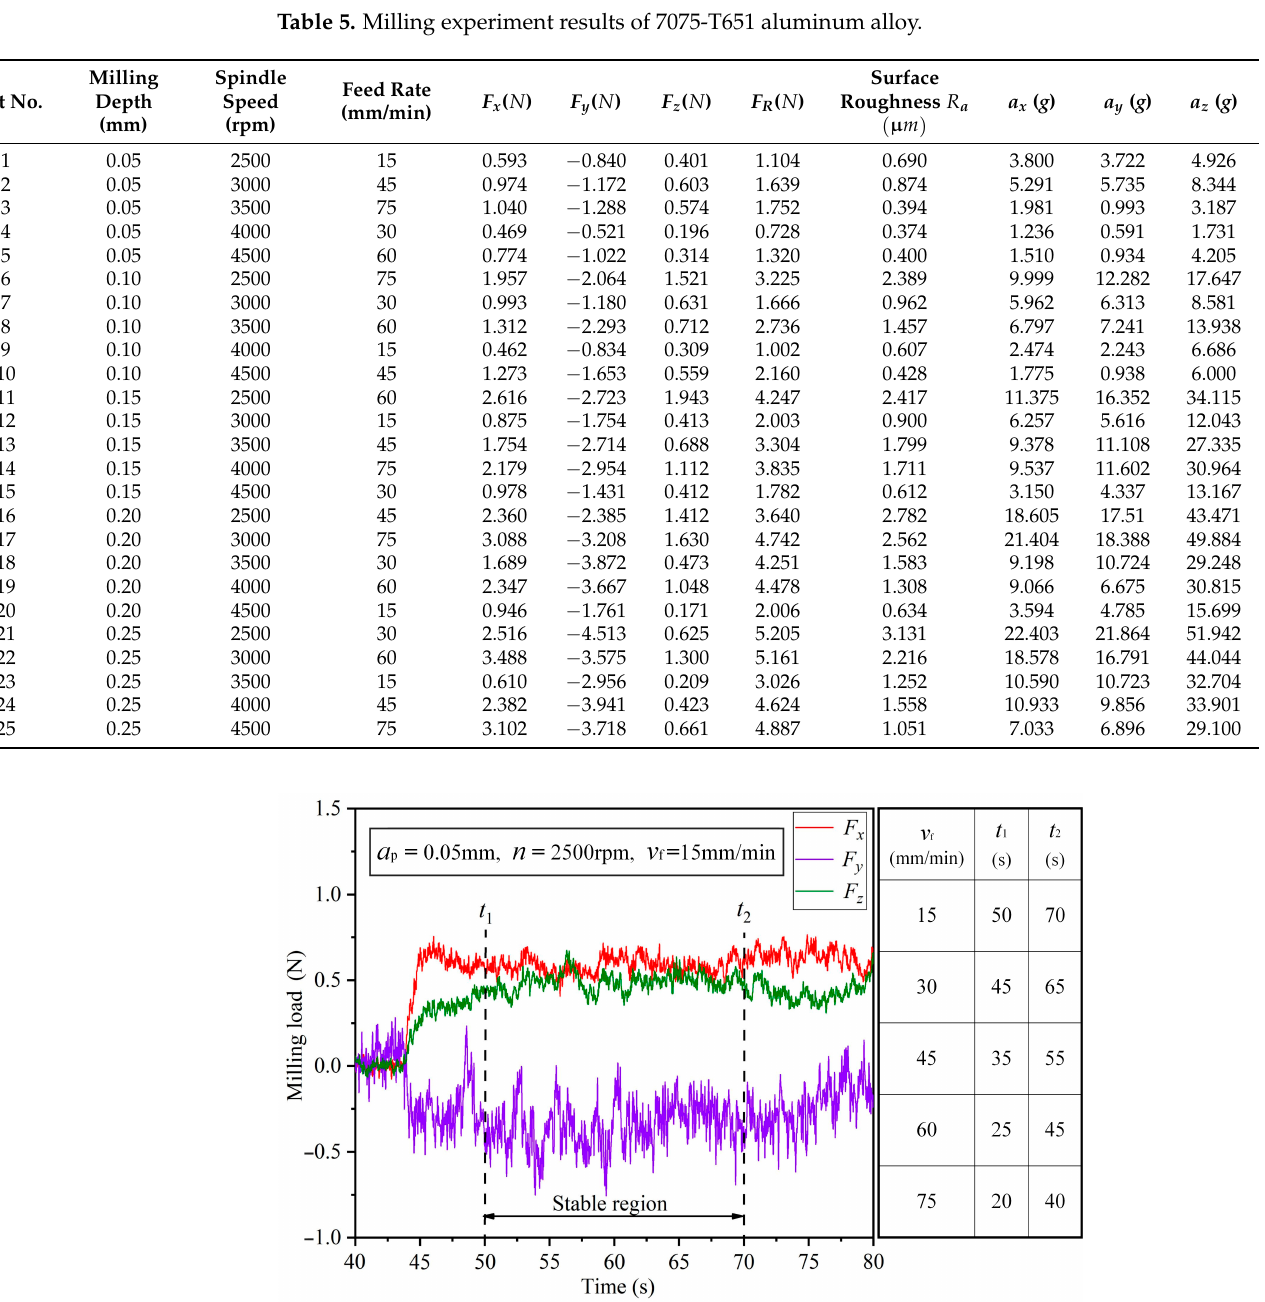
Figure 3. Milling load component in three directions. The contribution ratio based on the analysis of variance (ANOVA) was introduced to statistically investigate the relation between parameters and milling load. Table 6 shows the ANOVA analysis results for milling load. Among them, E denotes the error; SS denotes the sum of squares of each factor; MS denotes the average sum of squares; D denotes the degree of freedom; F 0.05 ( 4, 12 ) = 3.26. F is a statistic. The results of variance analysis showed that the order of the significant influence on milling load is: milling depth—1; feed rate—2; spindle speed—3. Milling depth 𝑎 (cid:2926) is a highly significant influ- encing factor (HS), while feed speed 𝑣 (cid:2916) is a significant influencing factor (S), and spindle speed 𝑛 is not significant (NS). The contribution ratio of the above process parameters on the milling load is 69.25%, 5.78% and 23.32%, respectively. The milling depth has the maximum contribution ratio on the milling load and its contribution ratio is much larger than the spindle speed and feed rate. The contribution ratio of the spindle speed is similar to the error contribution ratio and it is considered insignificant. The main reason for the largest contribution ratio of milling depth is that the variation of milling depth directly changes the unit cutting area, while the variation of feed rate and spindle speed is to change the material removal thickness per unit time by changing the milling thickness per tooth, thereby indirectly changing the unit cutting area [37]. Table 6. Variance analysis results of milling load orthogonal experiment. Factor